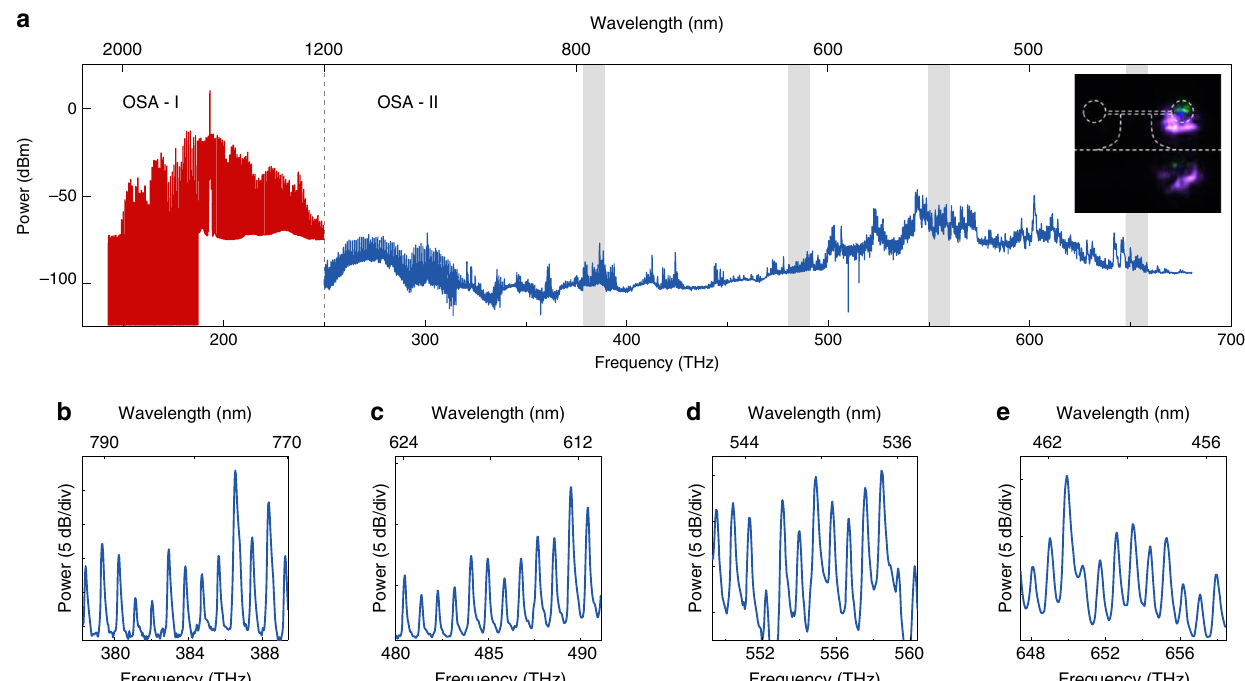
Fig. 2 Optical spectrum of two-octave-spanning microcombs. a Complete optical spectrum of microcombs. Spectrum measured with Yokogawa optical spectrum analyzer (OSA) above 1200 nm is presented in red, while the shorter wavelength part is measured by an Andor spectrograph (shown in blue). The absolute power of the spectrum are calibrated at 1550 and 635 nm for the OSA and spectrograph, respectively. The power mismatch of the red and blue spectrum at 1200 nm is caused by the spectrograph ef fi ciency variation over the broad spectral range. Inset: an image taken by a CCD camera on the side of the cavity. Green and violet emissions are apparent. b – e Zoom-in spectra of the gray areas are shown in panel a . The frequency ranges for b – e are